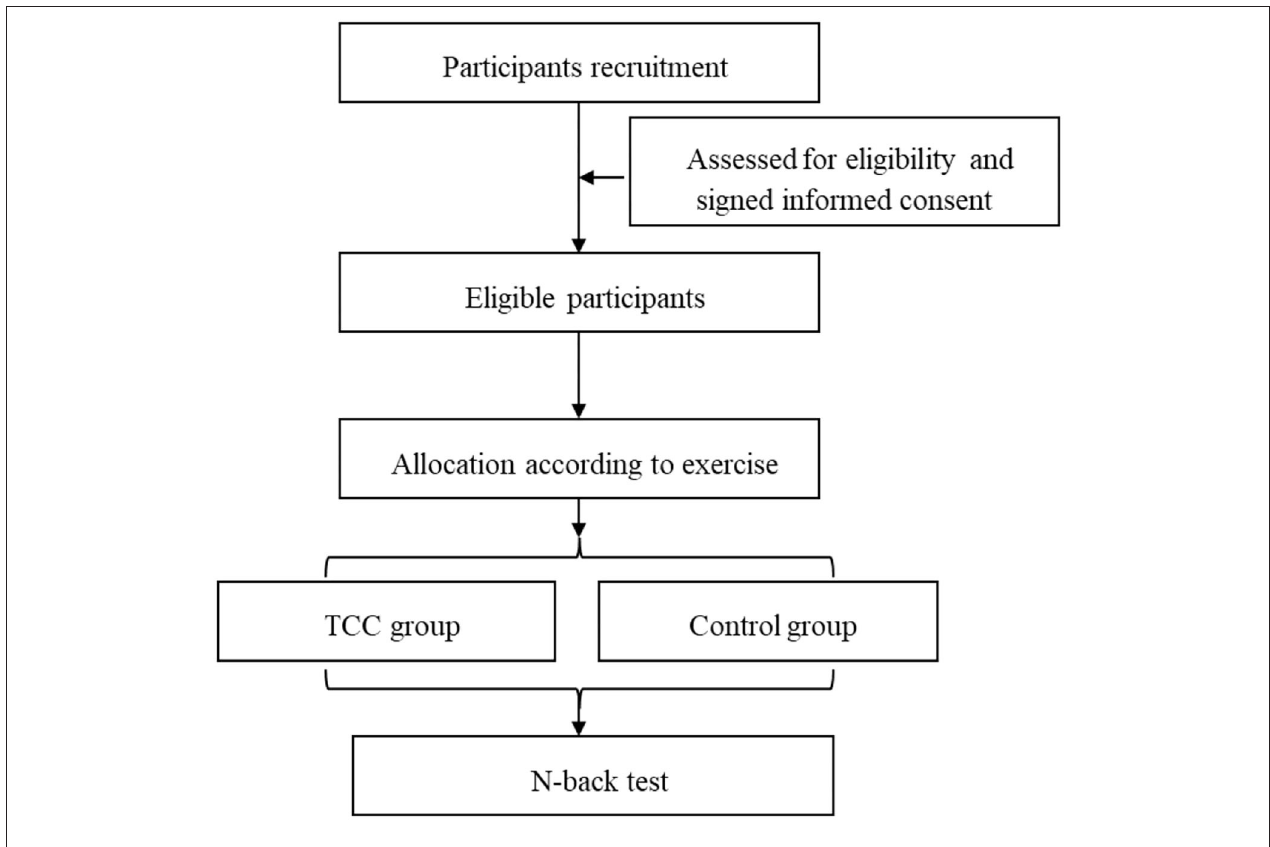
FIGURE 1 | Flow diagram of the study design.